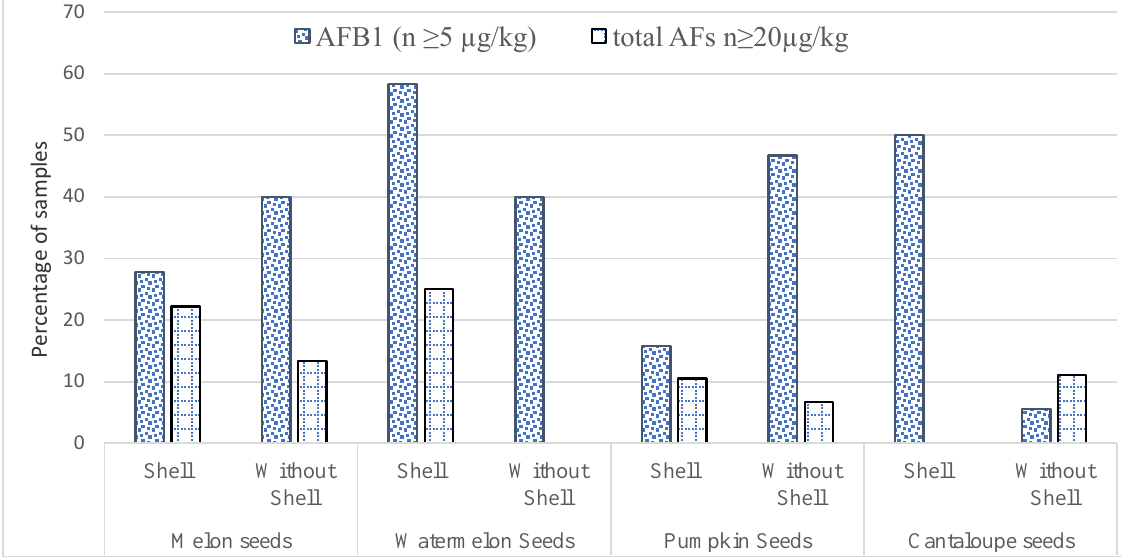
Figure 2. The number of AFB 1 and total AFs (µg/kg) samples higher than the recommended EU limits from the summer season.